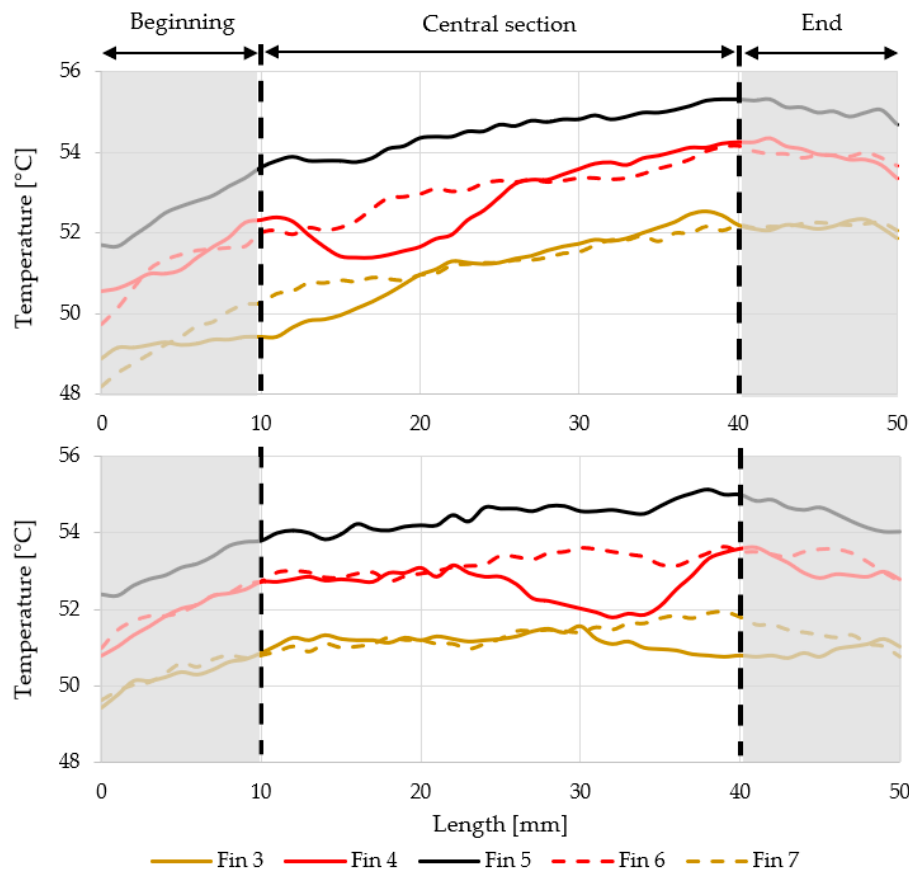
Figure 11. Temperature fields on the heat sink’s fins, top —“default” position, bottom —“upside-down” position.